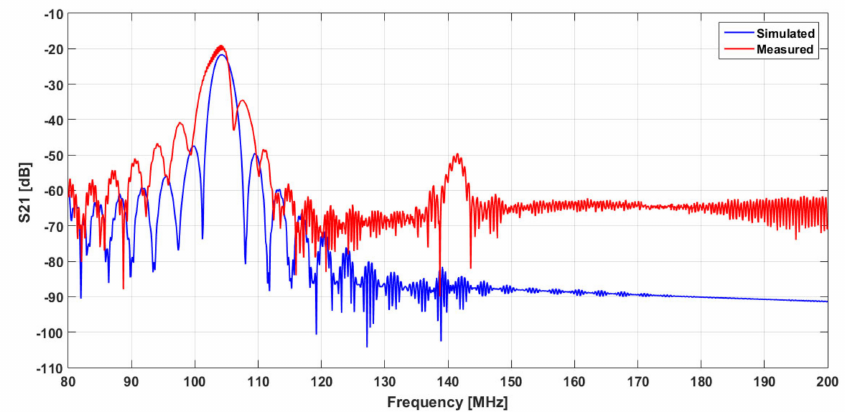
Figure 5. Simulated (2D model COMSOL of configuration: 30 pairs of double fingers + metallized sensitive area of 8 mm length) and measured S21 spectra of SAW delay line.